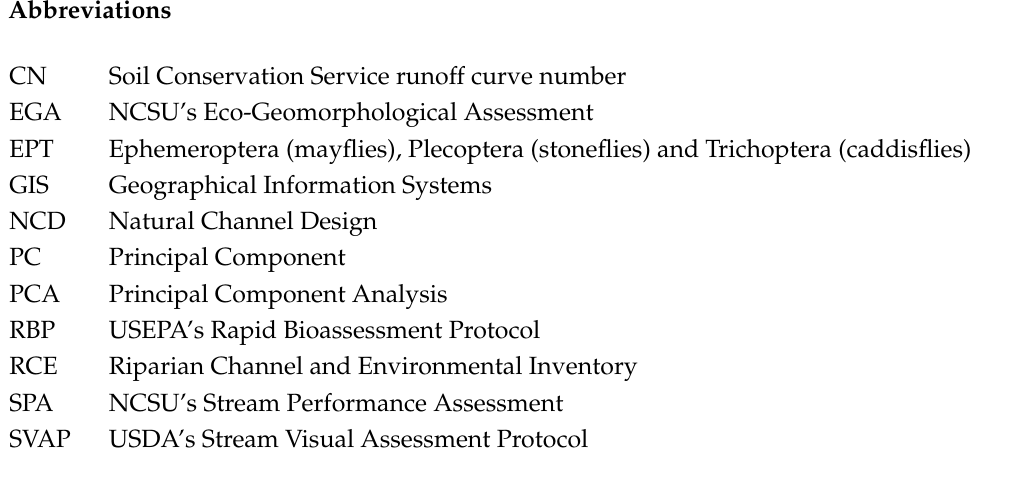
weights, Table S9: Stream Visual Assessment Protocol (SVAP) index (including watershed factors) scaled and un-scaled (multiplier)